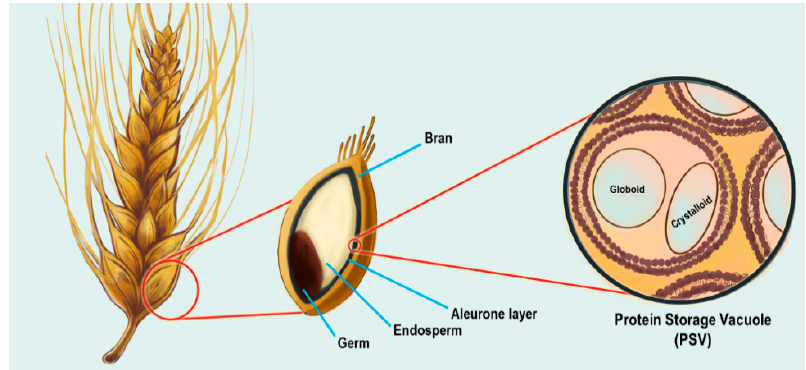
Figure 2. Diagram illustrating phytate storage in wheat granules. Phytate and other cations are stored in the protein storage vacuole (PSV) within small, crystalline storage bodies, known as globoids [9,15]. While the location of globoids varies across species, a majority of these are found within the aleurone layer of cereal crops, such as wheat and barley, as well as oilseed crops including peanuts, hemp, sunflower, and cotton [6,9,16]. Maize globoids are concentrated within the germ, whereas soybean phytate is distributed throughout the entire seed [6,17,18]. PSVs also contain crystalloid bodies, containing stored proteins and lipids [9].